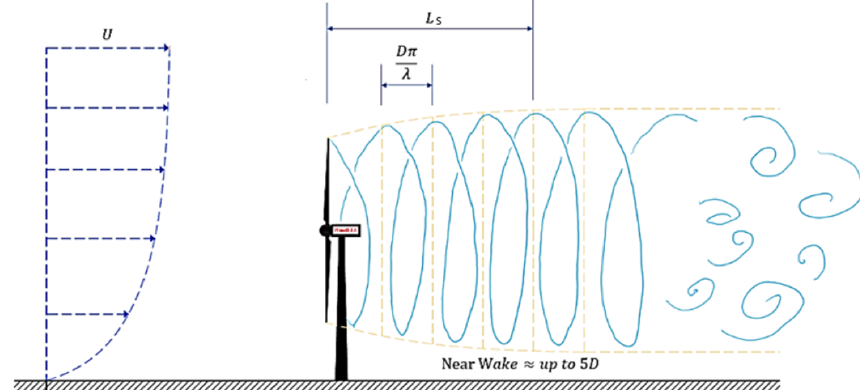
Figure 7. Visual representation of the length and the timescale relevant to the extreme conditions when assuming a symmetric